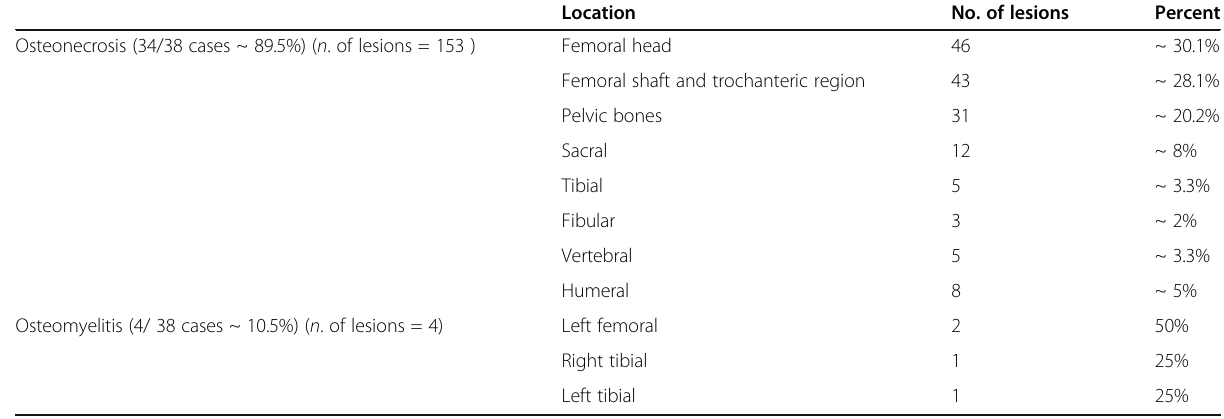
Table 3 Location of focal signal abnormality marrow lesions (number of cases = 38/42, ~